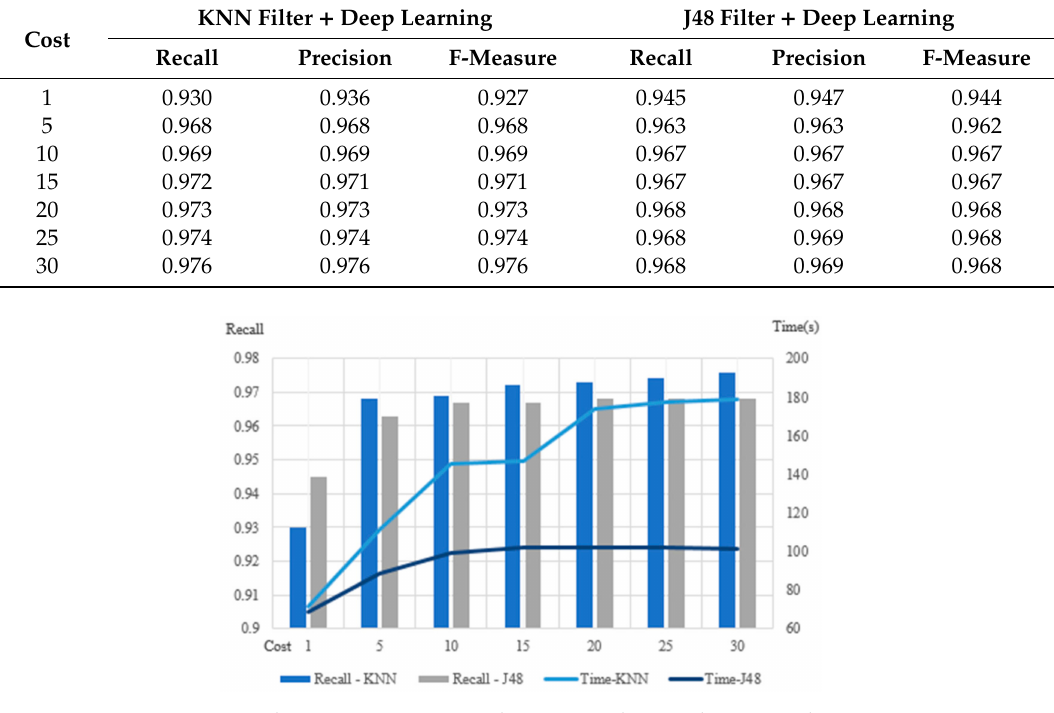
Figure 6. Changes in accuracy and time according to changes in the